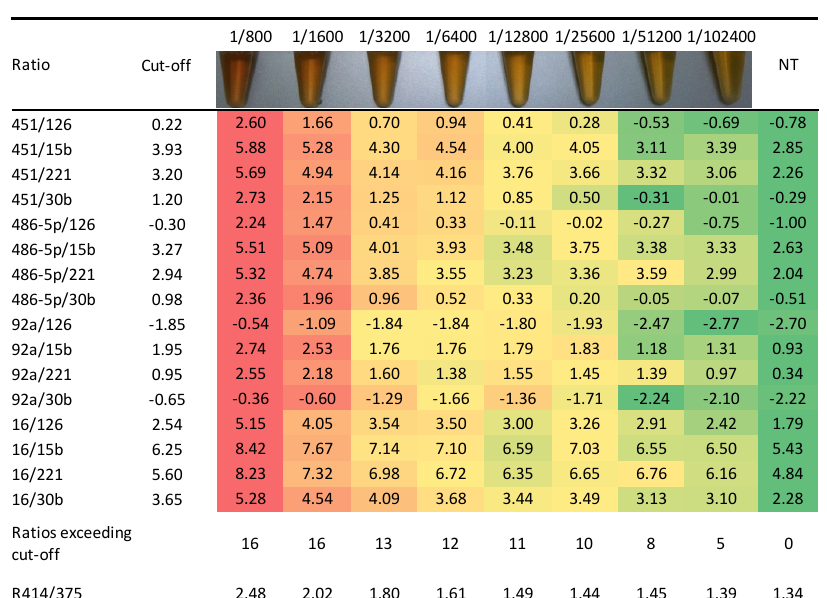
) for in vitro haemolysis evaluation. 2